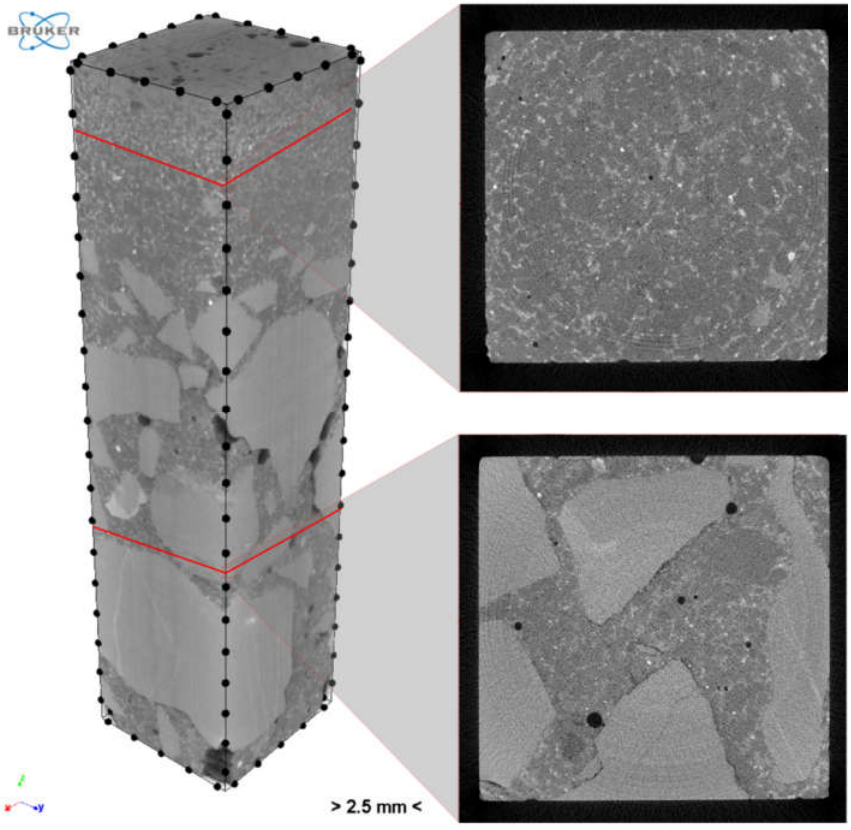
Figure 29. Reconstructed structure of sample with exemplary cross sections.